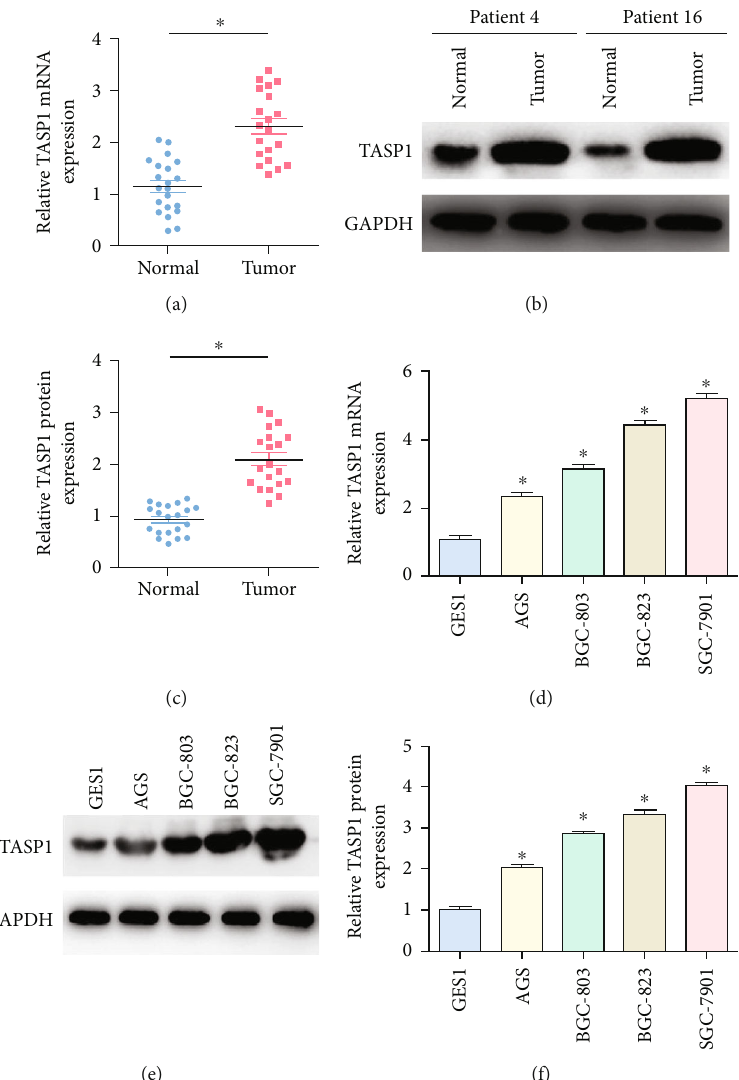
Figure 1: TASP1 is overexpressed in GC tissues and GC cells. (a) The expression of TASP1 mRNA in GC tissues and matched normal tissues via qRT-PCR ð ∗ p < 0 : 05 Þ . (b) The expression of TASP1 protein in tissues from patient 4 and patient 16. (c) The expression of the TASP1 protein in GC tissues of 20 patients. (d) The TASP1 mRNA expression in GES1 cells and GC cells (BGC-803, AGS, SGC-7901, BGC-823) ð ∗ p < 0 : 05 Þ . (e, f) The TASP1 protein expression in GES1 cells and GC cells (BGC-803, AGS, SGC-7901, BGC-823) ð ∗ p < 0 : 05 Þ